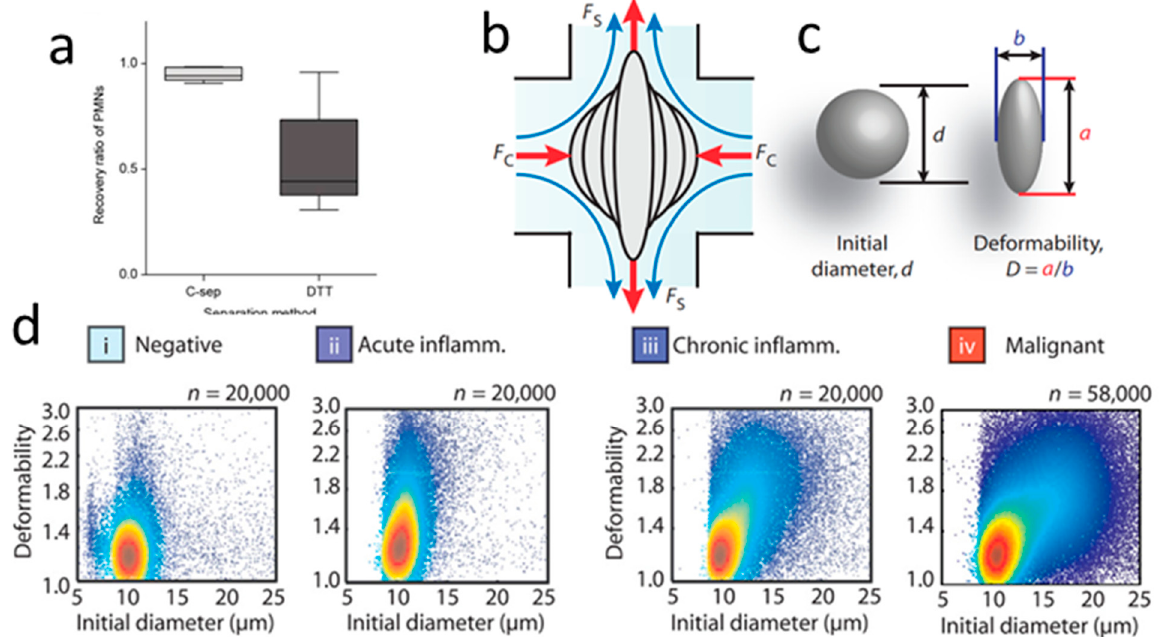
Figure 5. Separation and assaying of WBCs, from patients with respiratory illnesses. ( a ) The separation efficiency of the inertial microfluidic device (left) vs. traditional Sputalysin coupled centrifugation (right). Panel reprinted with permission from [95], Copyright 2017 American Chemical Society. ( b ) Schematic of how cell deformation occurs in inertial focusing and ( c ) measurements before and after deformation. ( d ) Sample output of the device, plotting size versus deformability, and representative plots of a negative (i) diagnosis, acute inflammation (ii), chronic inflammation (iii), and detection of malignant cells (iv). Panels b-d reprinted from [114], with permission from AAAS.